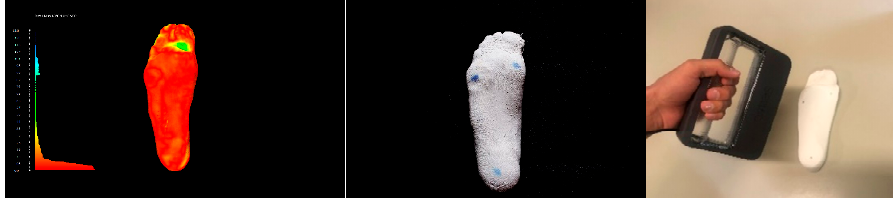
Figure 1. Comparison of ten plaster casts obtained after footprint recording with pinstripe and subtalar joint bandage in the neutral position (a neutral suspension cast).